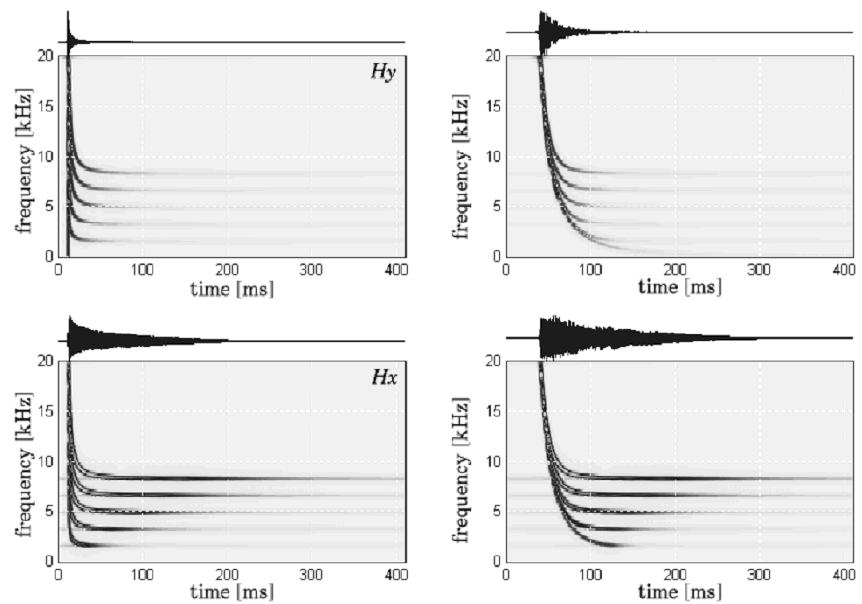
Fig. 10. Results of real full-wave modelling of long spheric propagation in the EIWG, appearing as a tweek, with and without the basic TEM mode, at a ground receiving station’s loop (left column) and of a subsequent impulse propagation across the inhomogeneous ionosphere, forming SpW signals, observable on board the LEO satellites. (This model calculation was assuming Dirac excitation, 3500-km long propagation along the x axis in a vacuum-filled EIWG and a vertical propagation across the mid-latitude ionosphere to a LEO satellite at 700km altitude.)